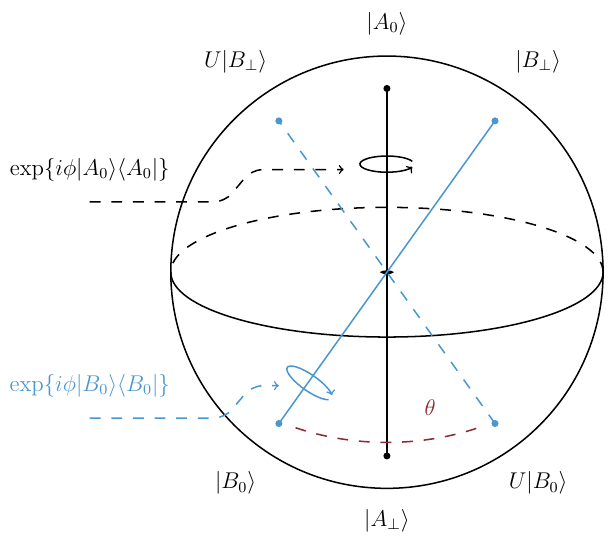
FIG. 2. An illustration of amplitude amplification, where one desires to prepare the state | A 0 (cid:6) (here, the north pole of some Bloch sphere) obliviously to this state, given only | B 0 (cid:6) , an oper- ator U the (cid:8) A 0 | U | B 0 (cid:6) = a component of which is nonzero, and the ability to rotate about the states | B 0 (cid:6) (blue) and | A 0 (cid:6) (black) through chosen angles. The standard Grover iterate can be recov- ered in this model if one desires, by producing a simple rotation by θ = 2 cos −